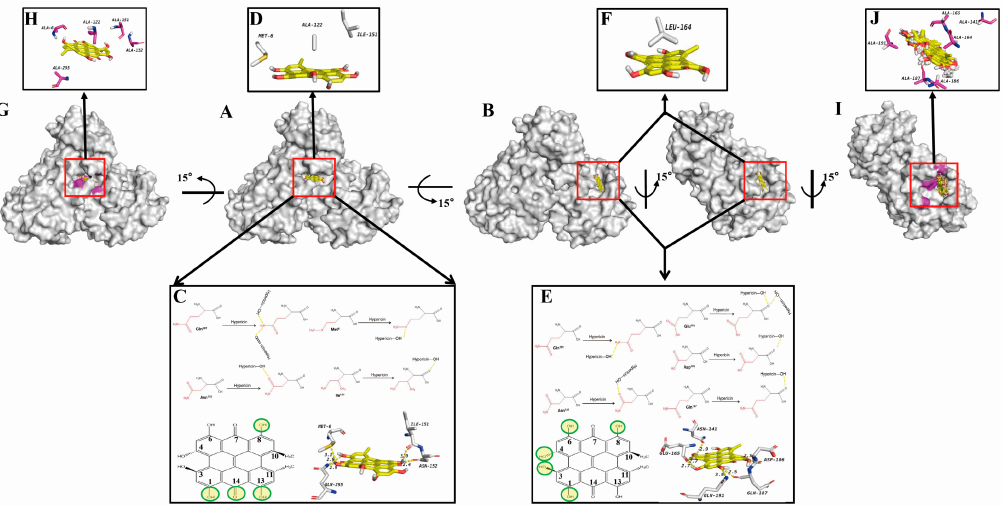
Figure 3. Molecular docking results of hypericin onto PEDV 3CLpro. The docking results were visualized by PyMOL. The main chains of amino acids are shown in black, and the side chains are shown in red. Hypericin is shown as yellow ligand, hydrogen bond is indicated as yellow dashed lines, and the atoms in hypericin interacting with amino acids are shown as yellow circles. The overview of solution 1 showing hypericin docked onto 3CLpro dimer with binding affinities of − 9.4 kcal/mol ( A ) or solution 2 in 3CLpro dimer (left) and monomer (right) with binding affinities of − 9.9 kcal/mol ( B ). The hydrogen bond interactions of hypericin with Ile151, Asn152, Gln295, and Met6 in 3CLpro dimer ( C ), and Asn141, Glu165, Asp186, Gln187, and Gln191 in 3CLpro monomer ( E ). ( D ) Hydrophobic interaction of Met6 and Ile151 in the dimer B chain and Ala122 in the dimer A chain with hypericin. ( F ) Hydrophobic interaction of Leu164 with hypericin in the monomer. ( G , H ) The docking results of hypericin with dimer of PEDV 3CLpro mut . ( G ) The overview of the docking of hypericin and dimer of PEDV 3CLpro mut . ( H ) Met6Ala, Ile151Ala, Asn152Ala, and Gln295Ala in dimer. ( I , J ) The docking results of hypericin with monomer of PEDV 3CLpro mut . ( I ) The overview of the docking of hypericin and dimer of PEDV 3CLpro mut . ( J ) Asn141Ala, Ile164Ala, Glu165Ala, Asp186Ala, Gln187Ala, and Gln191Ala. Hypericin is shown as yellow ligand, and the mutated residues are shown in